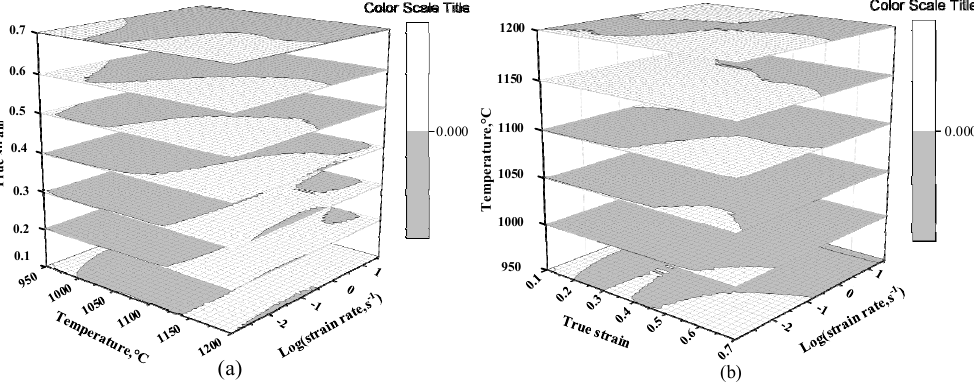
Figure 10. Three-dimensional flow instability maps at various conditions: ( a ) Three-dimensional flow instability map at strain ranges of 0.1–0.7; ( b ) Three-dimensional flow instability map at 950–1200 ◦ C. Figure 10a is a 3-D flow instability diagram with strain ranges of 0.1–0.7. It is shown that the